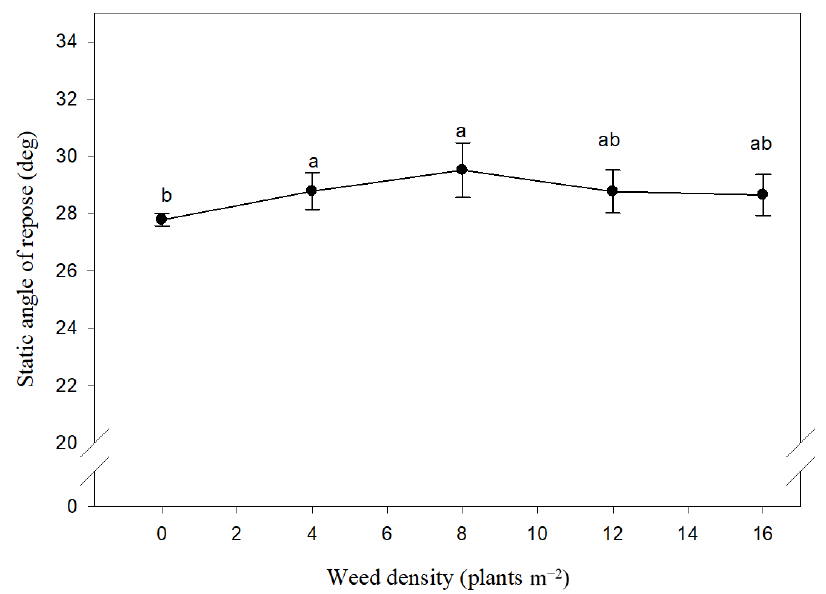
Figure 6. Effect of different density of Xanthium strumarium and Datura stramonium on angle of repose of maize seeds. Mean values with the same letters are not significantly different based on Tukey’s studentized range test ( p ≤ 0.05). Vertical lines are standard error of mean ( n = 12; two years, two weed species and three replications).